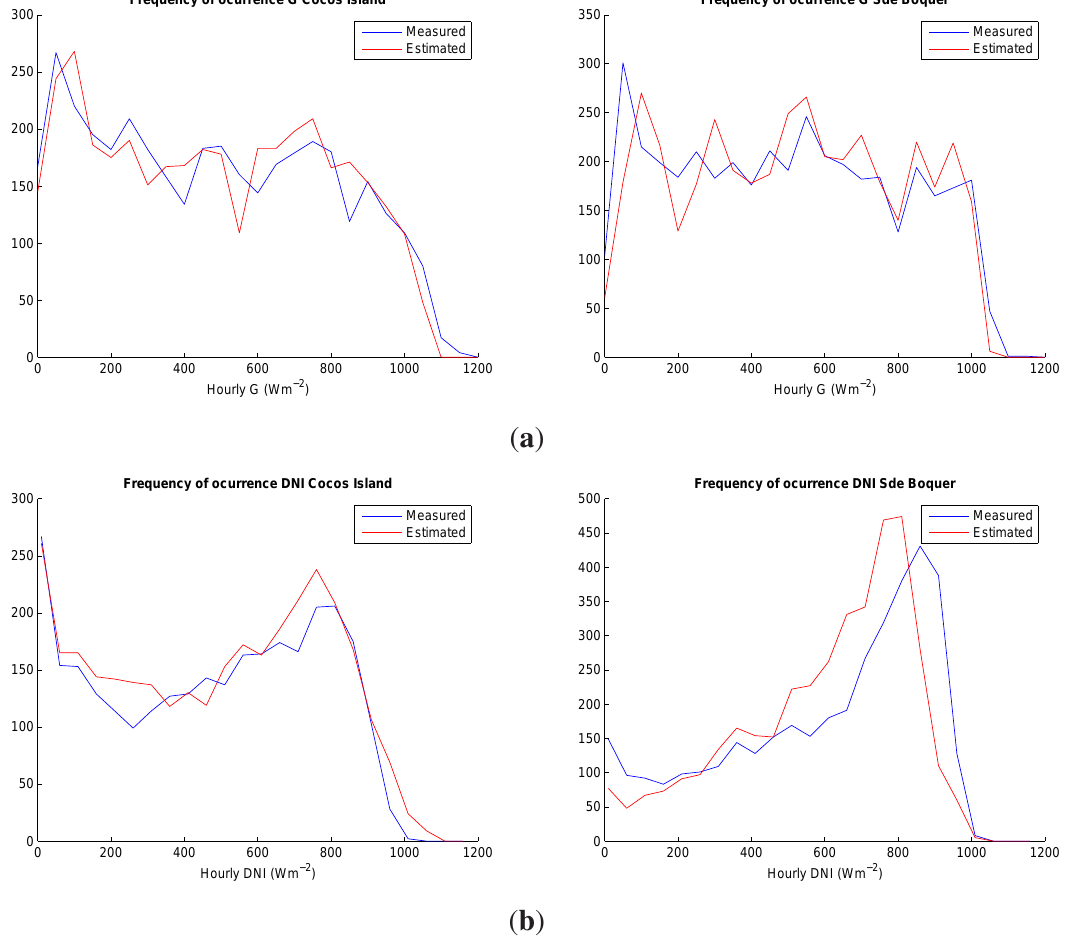
Figure 2. Comparison of irradiance probability density functions for two stations (Cocos Island and Sde Boqer). ( a ) Global horizontal irradiance; ( b ) Direct normal